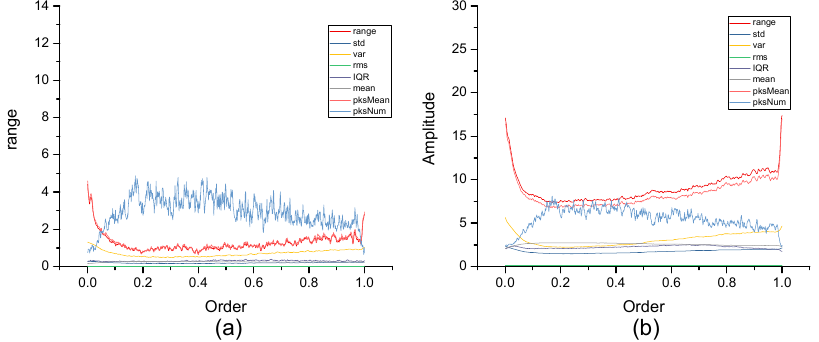
Figure 9. Standard deviation and mean of eight features of the dwstairs action. ( a ) The standard deviation of each feature, ( b ) The mean of each feature. Table 4. Mean and min of standard deviation of each feature of dwstairs.